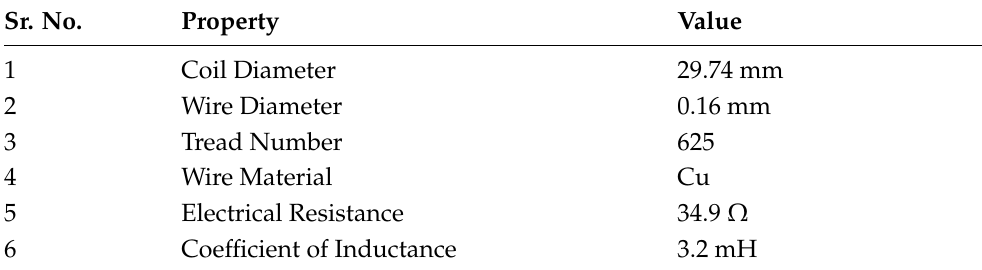
Figure 4. ( a ) Front and ( b ) rear view of the base used to mount the blades on the motor. The Π shape of the base made it easy to close the metal container without the blades resting inside it as they rotated. Table 4. Physical and geometrical properties of the detection